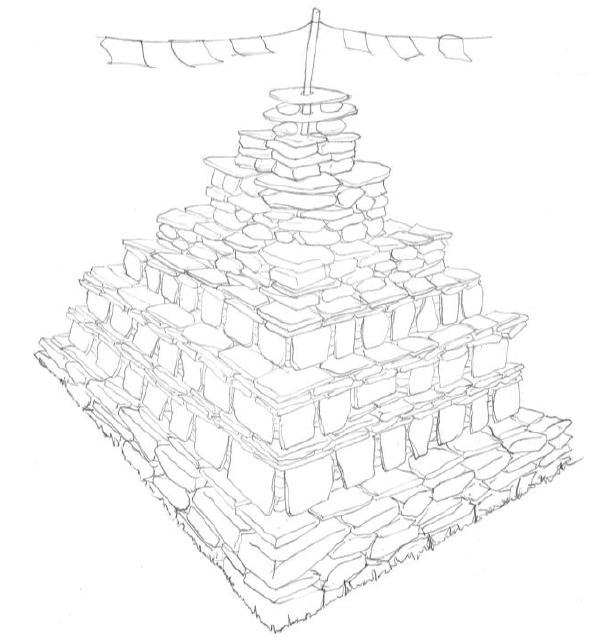
Figure 13. Axonometric drawing of stone chorten (Authors).